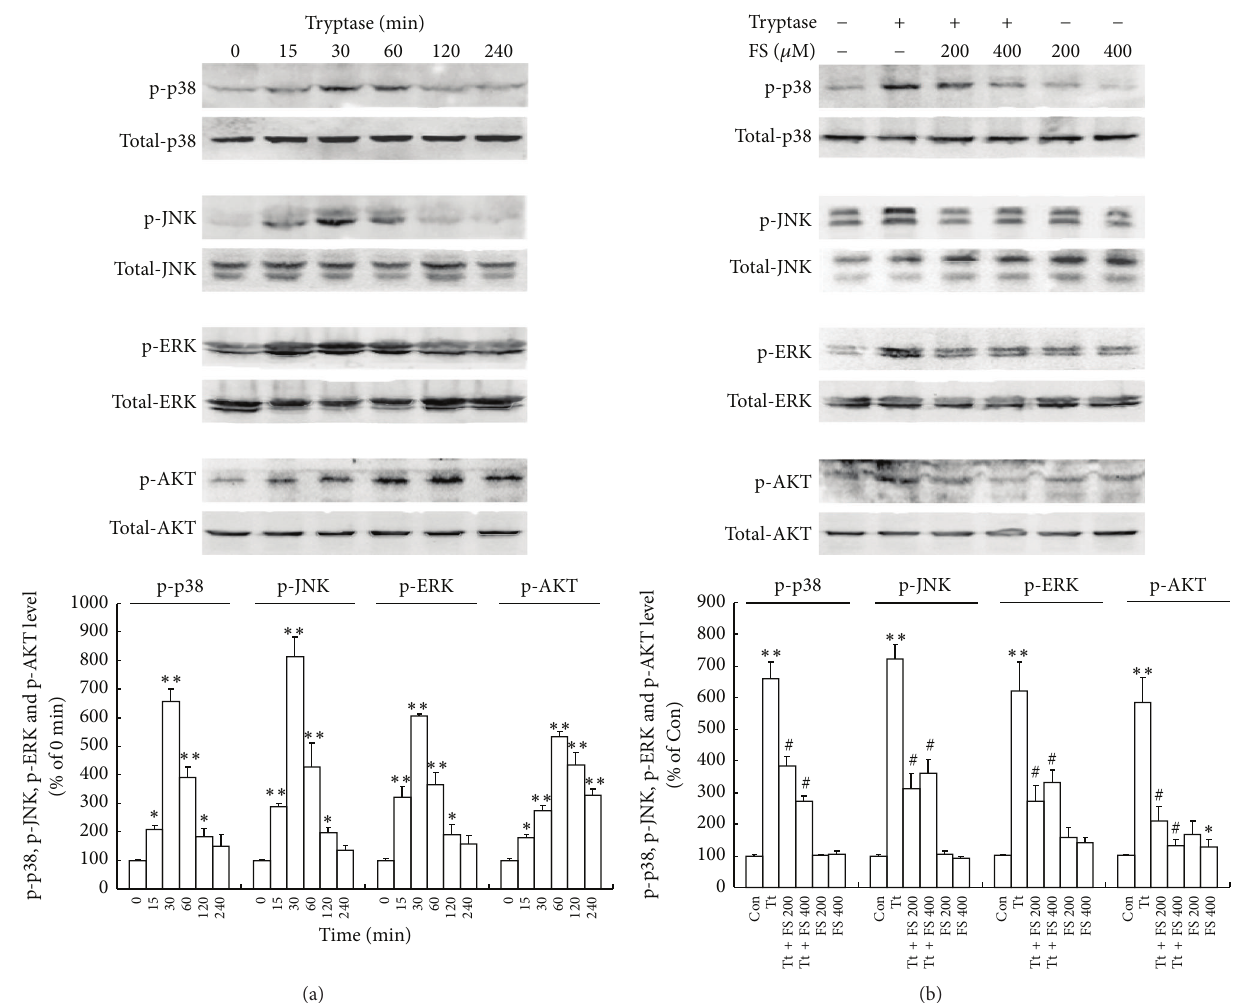
Figure 5: Effects of tryptase (Tt) on the activation of MAPKs and PI3K/AKT. (a) Time courses of tryptase activated p38, JNK, ERK, and AKT, which was assessed by increased phosphorylation of tyrosine residues of these kinases. Astrocytes were incubated with 1 𝜇 g/mL of tryptase for the indicated periods (0, 15, 30, 60, 120, and 240 min). (b) FSLLRY-NH2 (FS, 200 or 400 𝜇 M) alleviated tryptase (1 𝜇 g/mL) induced MAPKs and PI3K/AKT activation. Astrocytes were incubated with 1 𝜇 g/mL of tryptase in the presence or absence of FS, an antagonist of tryptase at 37 ∘ C for 30 min. Activated p38 (p-p38), JNK/SAPK (p-JNK), ERK (p-ERK), and AKT (p-AKT) species were detected by immunoblot analysis with antibodies specific for the phosphorylated forms of each kinase. The amount of protein loaded in each lane was confirmed by measuring the amount of p38, JNK, ERK, and AKT reacted to the antibody against the unphosphorylated form of each kinase. This is a representative experiment independently performed three times. ∗∗ 𝑃 < 0.01 , ∗ 𝑃 < 0.05 versus control groups (Con), # 𝑃 < 0.05 versus corresponding tryptase treatment